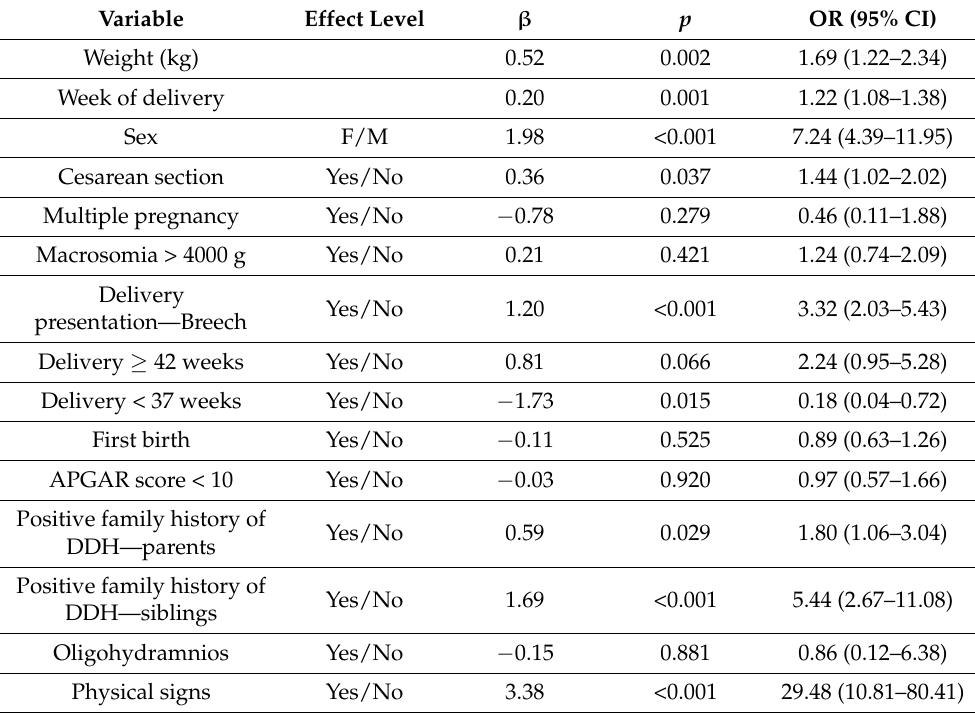
Table 4. Univariate logistic regression to evaluate DDH